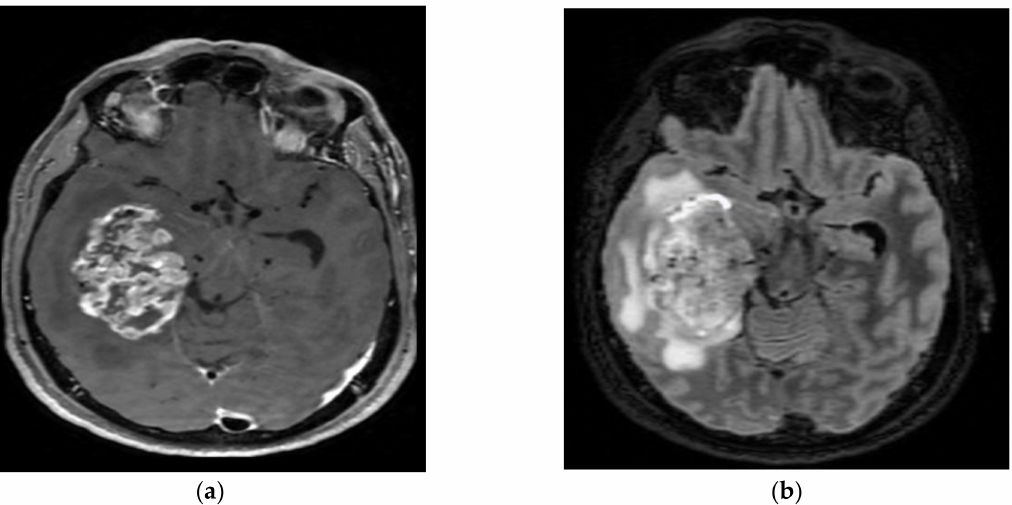
Figure 7. A 60-year-old male with right temporal lobe anaplastic pleomorphic xanthoastrocytoma. After surgical resection, the patient was treated with chemotherapy and radiotherapy at recurrence. ( a ) T1-weighted image after gadolinium infusion; ( b ) Flair-weighted